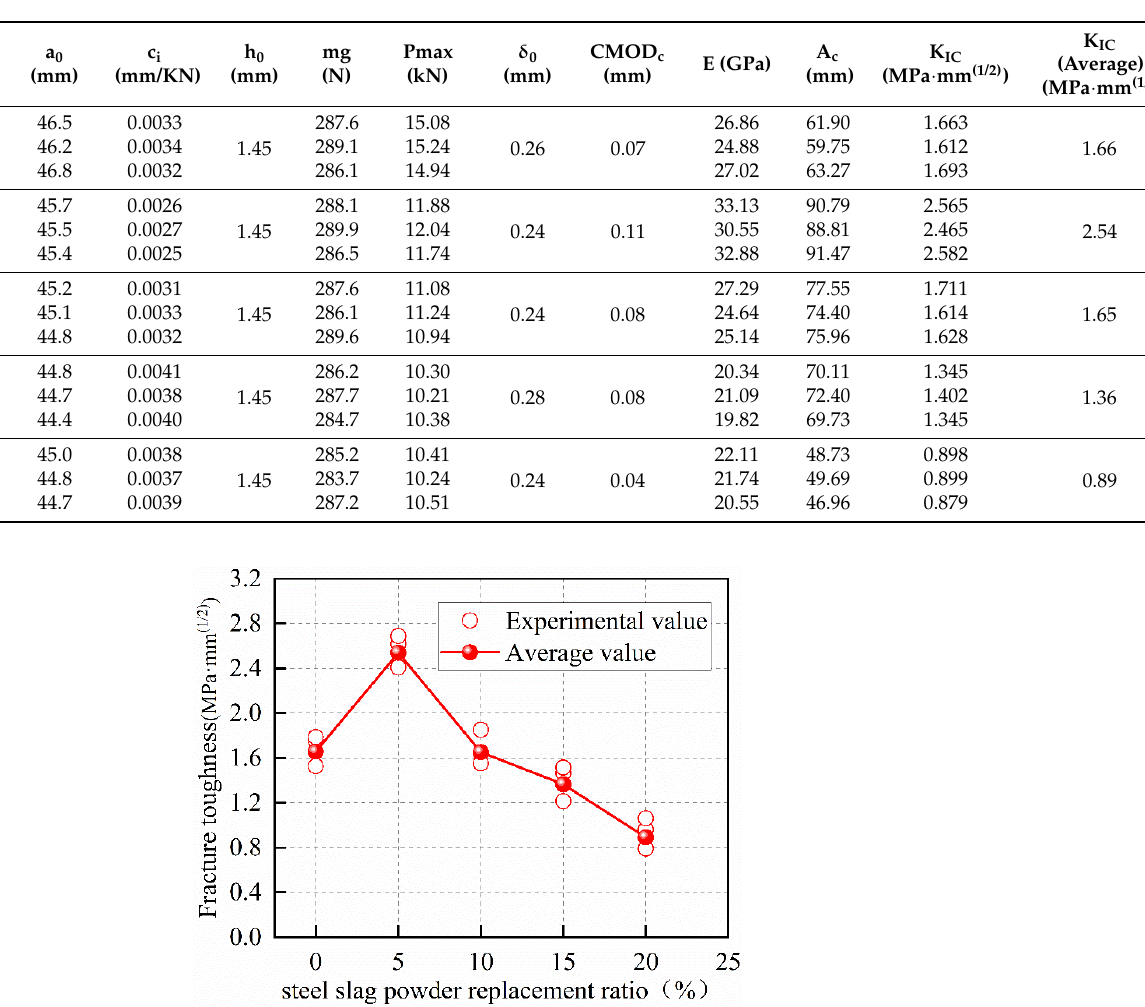
Figure 7. Load-crack-opening displacement curves (P-CMOD). Table 4. Parameters and values of stress-intensity factor of the specimens.